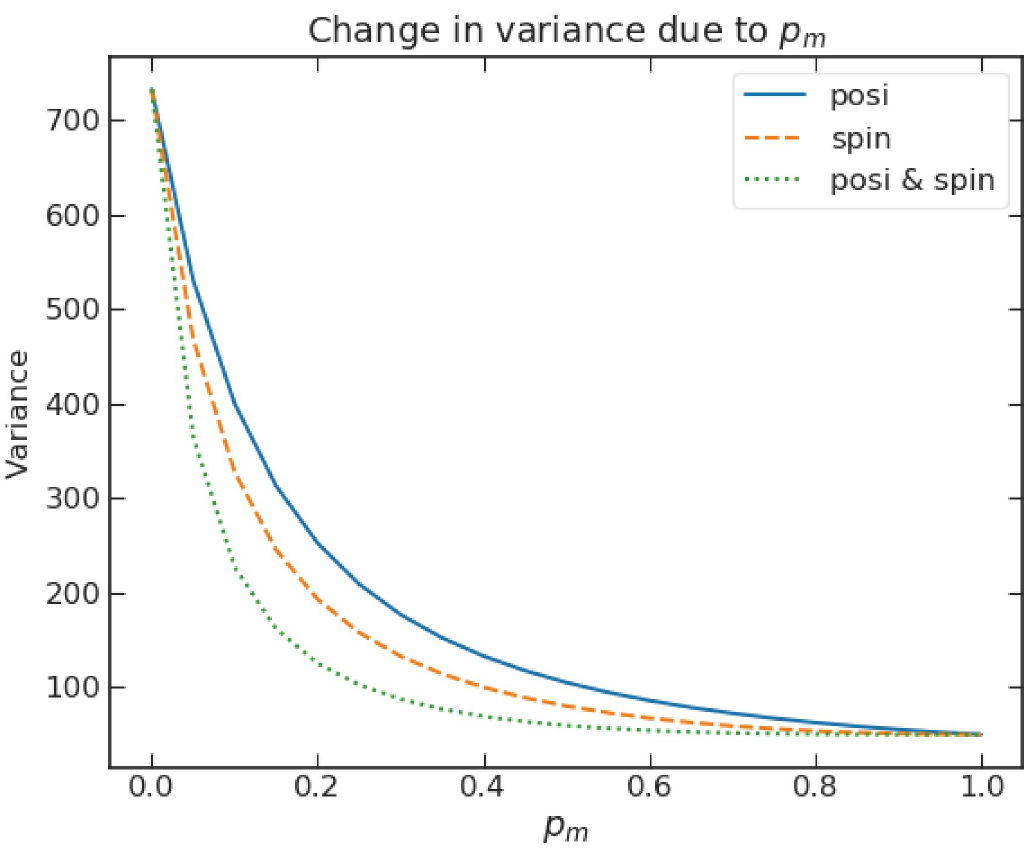
Fig 6. Variance of the mixed walk vs p for the three types of measurement discussed in the text with parameters ρ = 0.5, η = m 0.5, ξ = 0, step sizes s L = s R = 1 at time t = 50 in an unbounded position